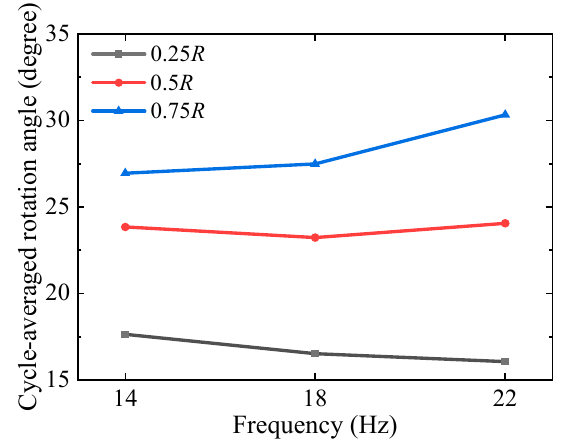
where T is the flapping period. With the increase of the flapping frequency, the deformation along the spanwise direction turns to be larger.